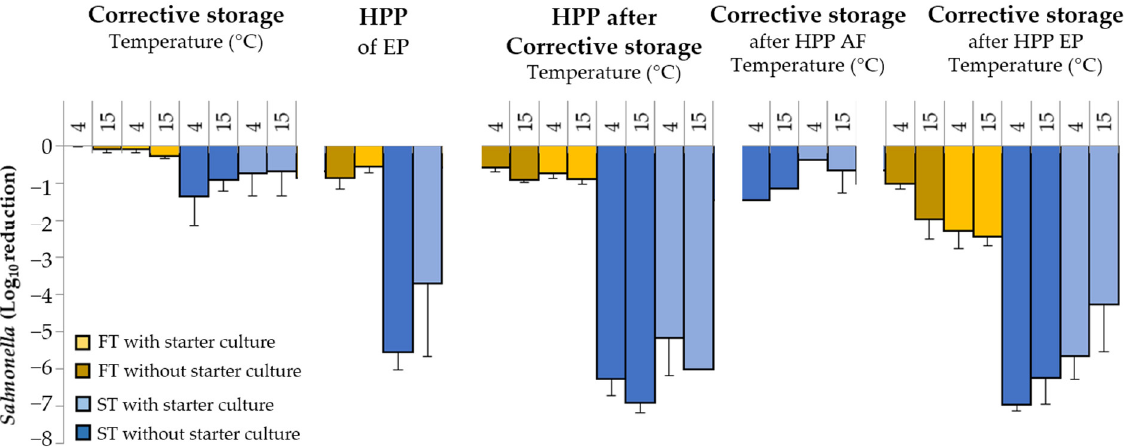
Figure 3. Inactivation of Salmonella (Log 10 reduction) of fuet -type (FT) and snack type (ST) without and with the addition of starter culture due to corrective storage (7 days at 4 or 15 °C) and/or HPP. Time of application of HPP and sampling are indicated. AF: After Fermentation; EP: End of Process. Error bars correspond to standard deviation of three replicates. For each type of product, a significant effect of the applied strategy is indicated with an asterisk.